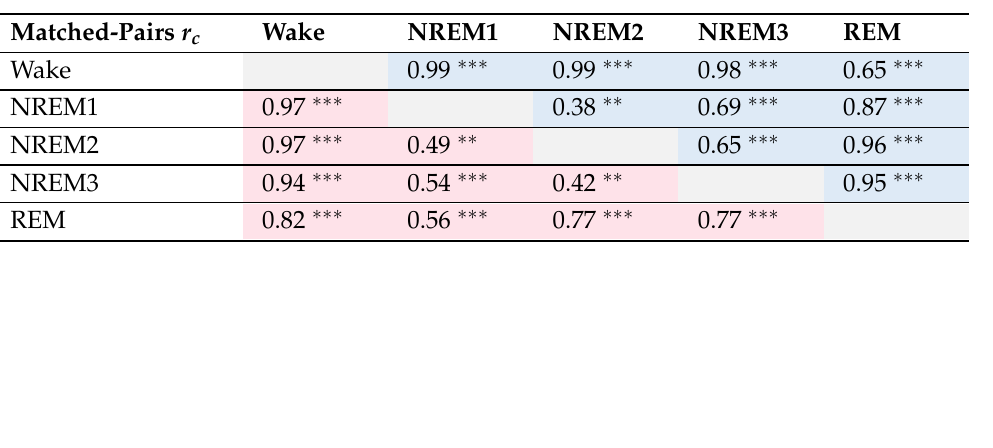
Table 3. The matched-pairs r c values of interquartile ranges of PAT distributions between different sleep stages after (blue background) and before post-processing (red background). p < 0.001 and r c ≥ 0.30 is marked ∗∗ , p < 0.001 and r c ≥ 0.50— ∗∗∗